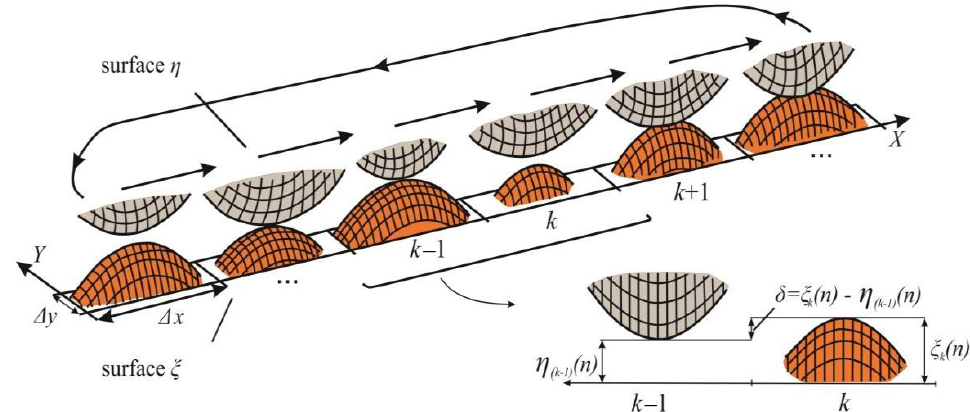
Figure 1. Model surface and the shift pattern. If limit distributions p ∗ and q ∗ exist, they are obtained from a system of nonlinear equations.